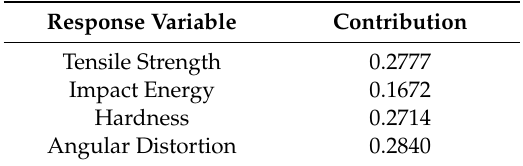
Table 9. Variance contribution of response variables for first